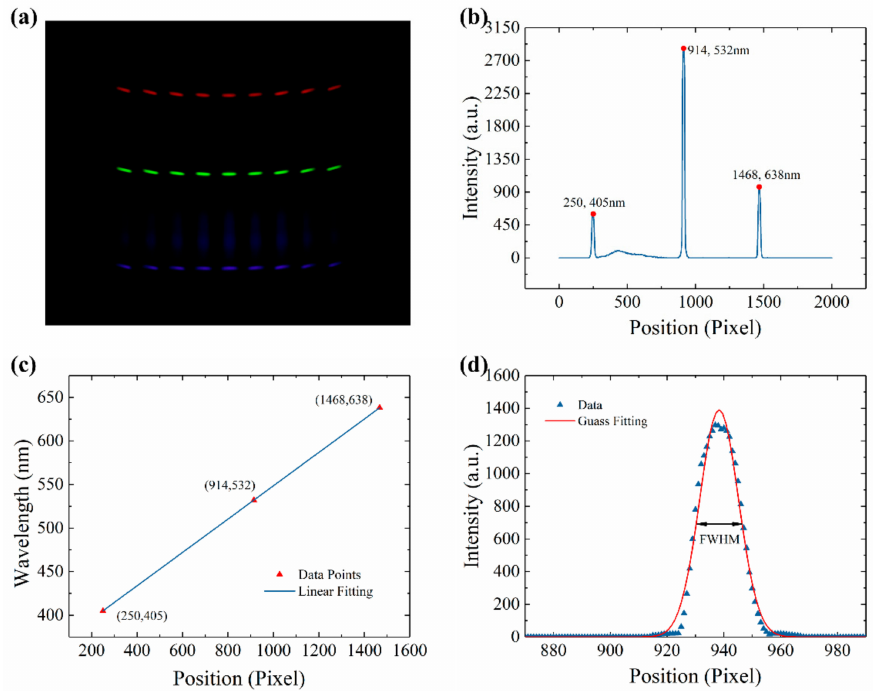
Figure 3. Spectral calibration results. ( a ) Picture of lasers taken by the smartphone; ( b ) Relationship between intensity and position in the picture of lasers; ( c ) Relationship between wavelength and position; ( d ) The spectrum of 532 nm laser and the Gauss fitting